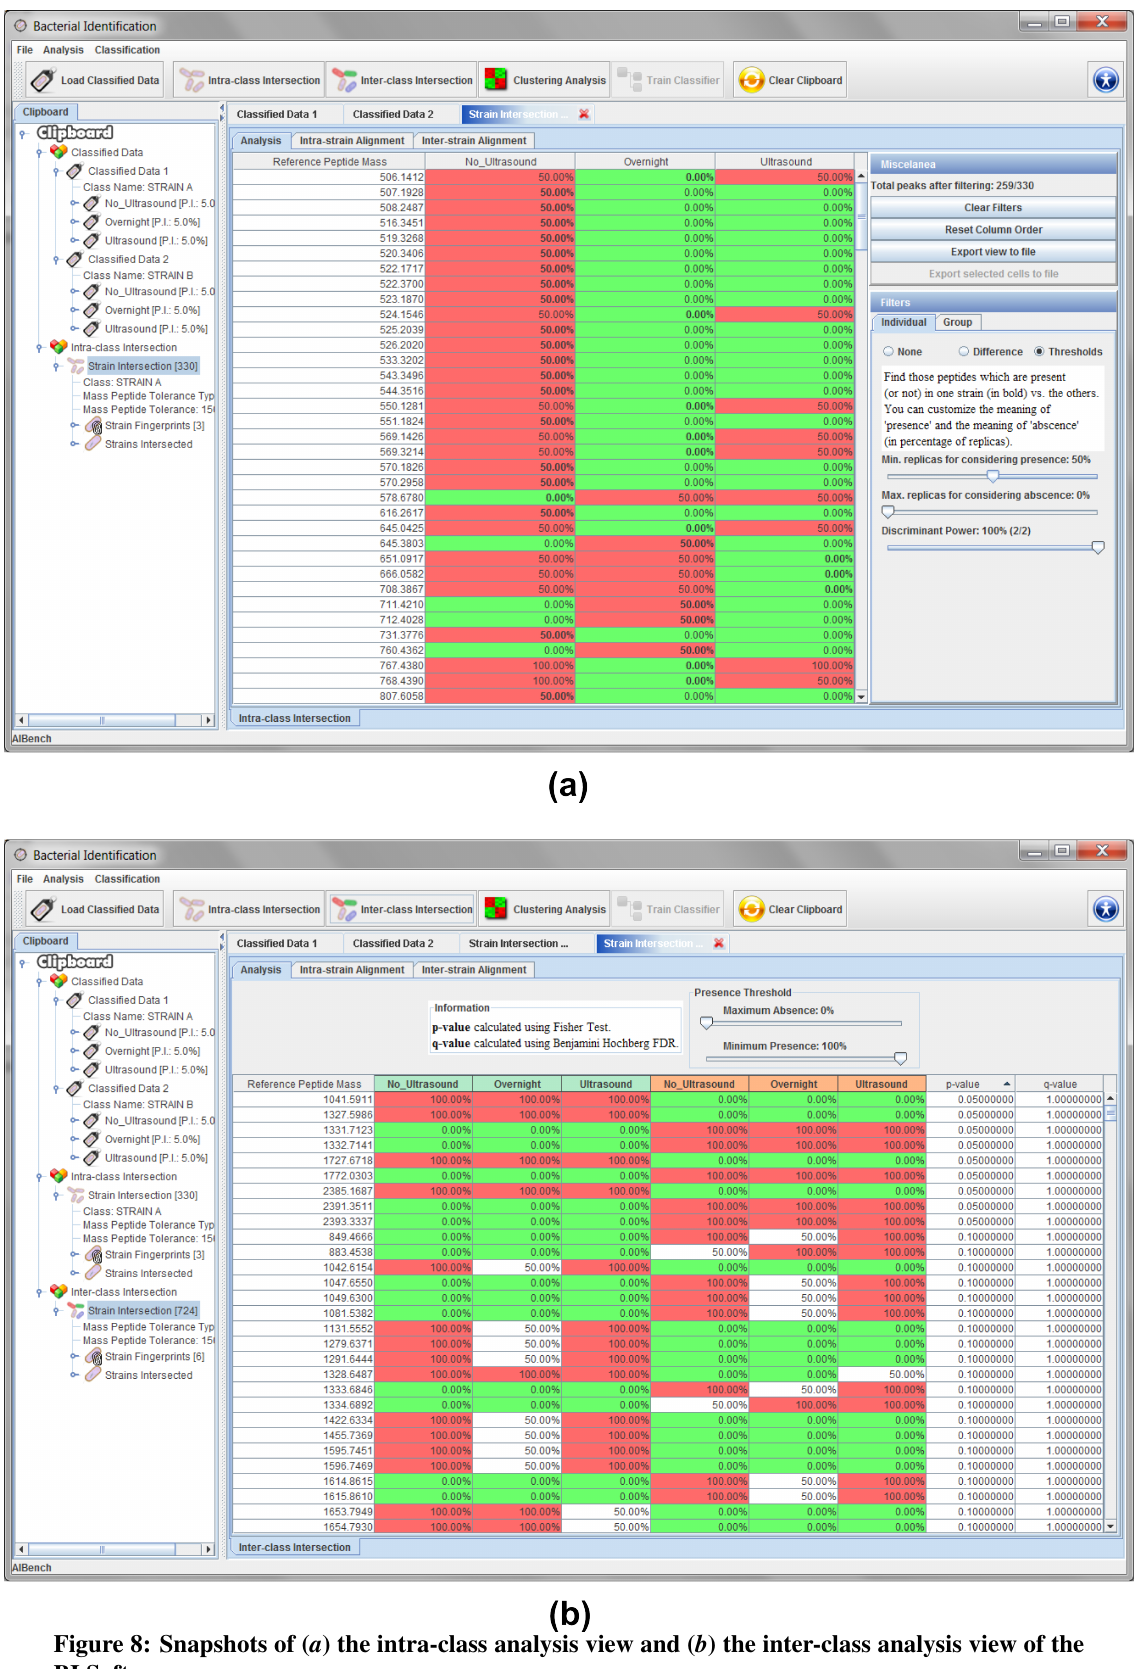
Figure 8: Snapshots of ( a ) the intra-class analysis view and ( b ) the inter-class analysis view of the BI